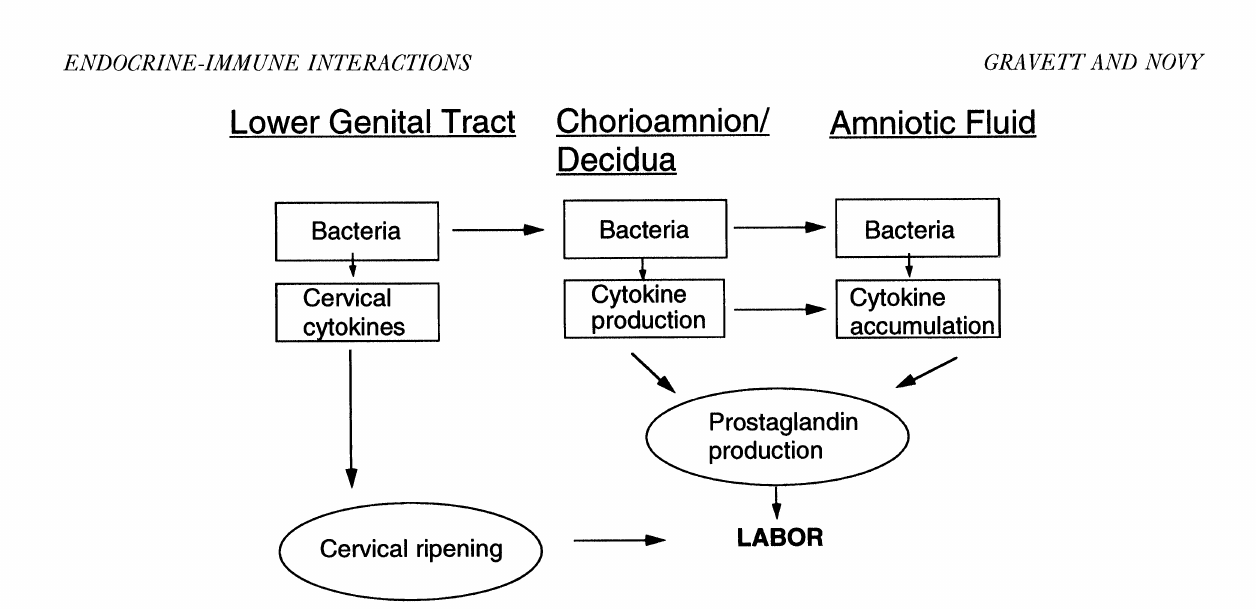
phages and neutrophils, release of proinflammator cyto- kines and prostaglandin or other eicosanoid production. Microorganisms may transgress the amnion and chorion, resulting in intraamniotic infection, activation of the fetal immune response and HPA axis, and amniotic fluid accu- mulation of proinflammatory cytokines and prostaglandins. Increase in prostaglandins, or other eicosanoids, may then stimulate myometrial contractions and